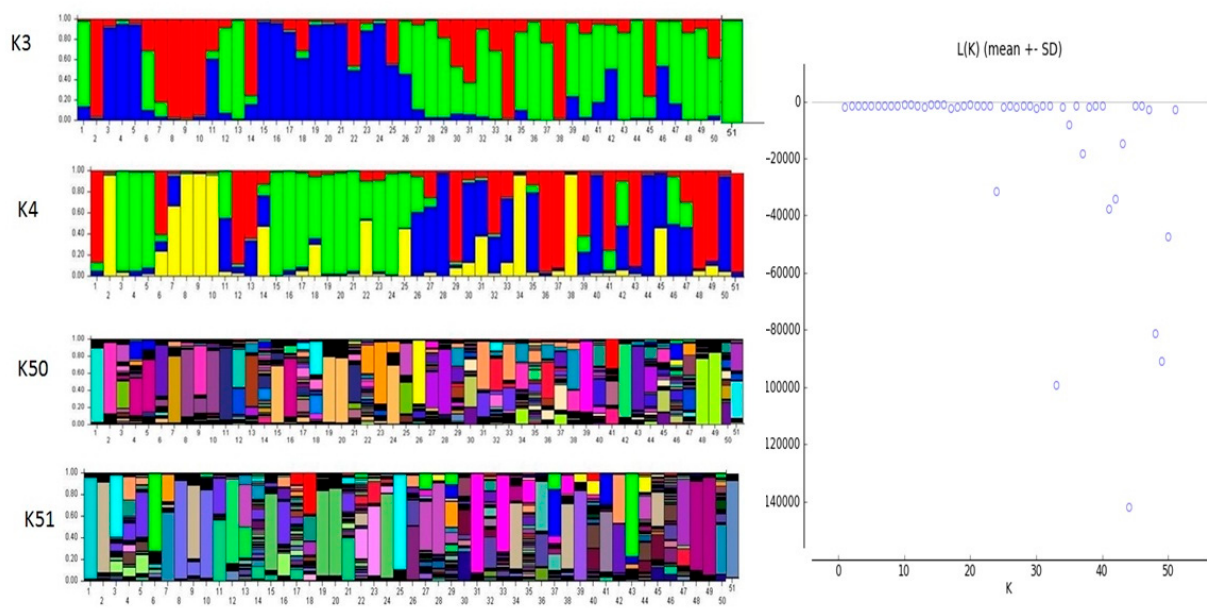
Figure 2. STRUCTURE analysis of Momordica accessions, based on the SSR data. Bars represent the membership coefficients of individual plants based on SSR allele frequencies, using K-values for three, four, fifty, or fifty-one groups. Numbers on the horizontal axes correspond to the population numbers in Table 1.